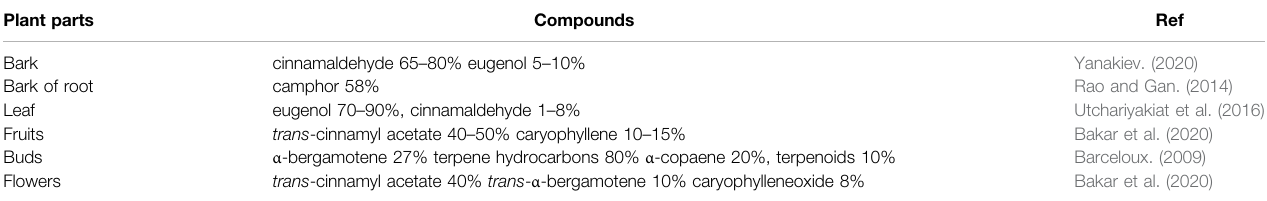
TABLE 1 | The most representative chemical compounds of Cinnamomum plants. Plant parts Compounds